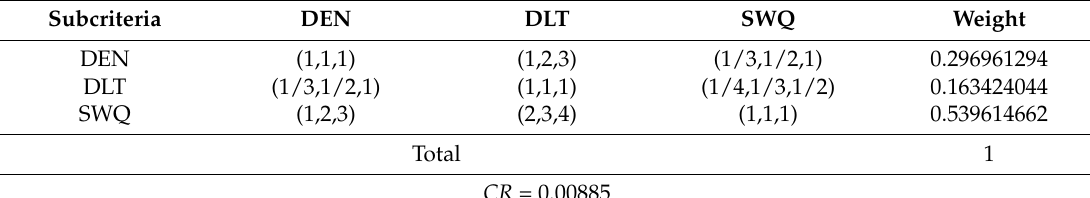
Table A10. Comparison matrix for DCU.